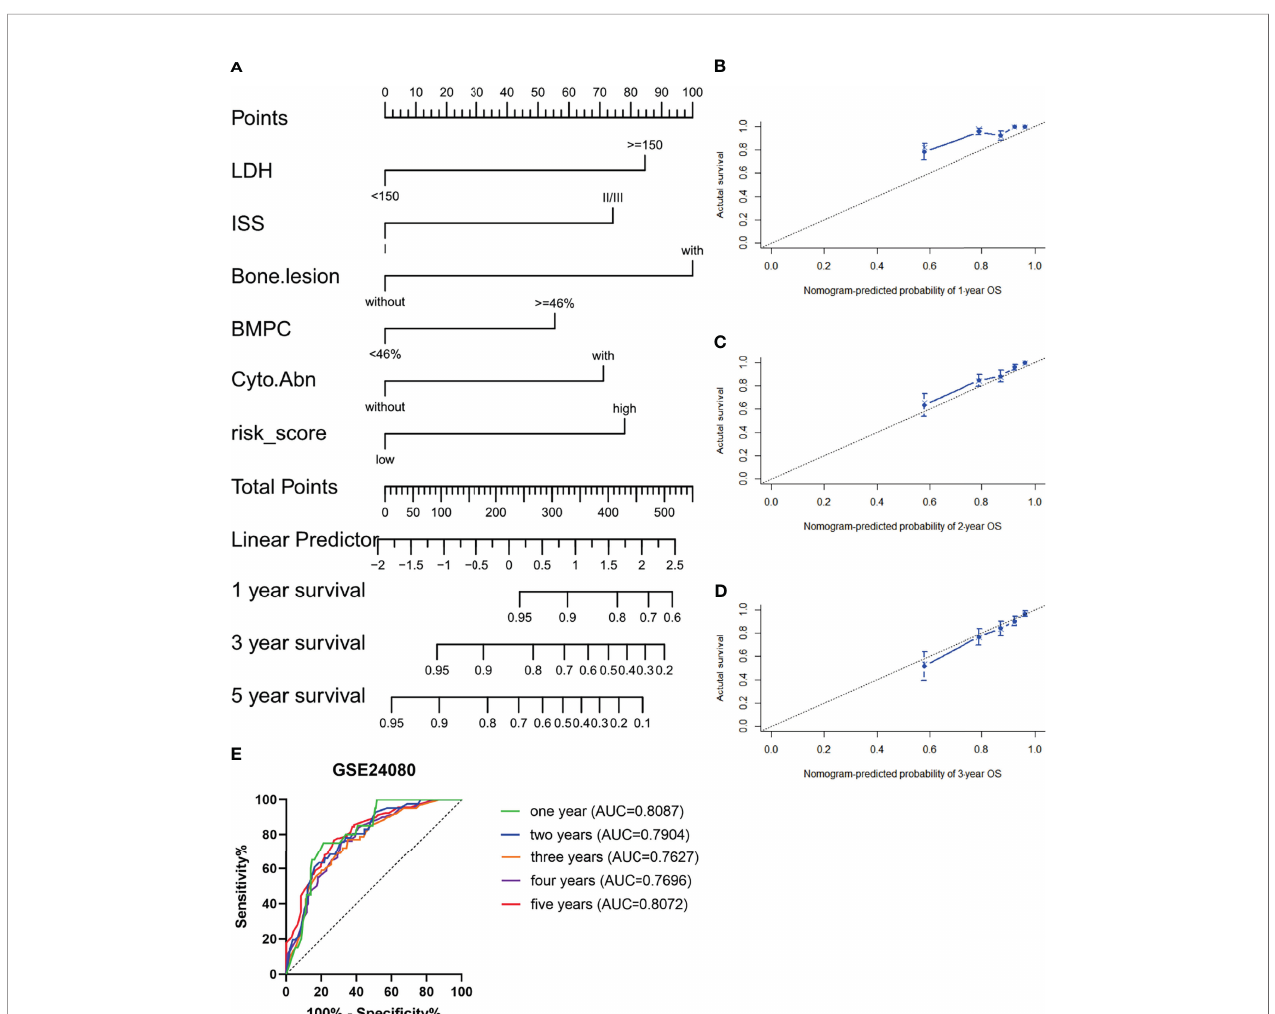
FIGURE 4 | Establishment and assessment of the nomogram. (A) Nomogram predicting 1-, 3-, and 5-year survival for MM patients in the training cohort based on the risk score and other clinical parameters. (B – D) Calibration plot of the nomogram for 1-year (B) , 2-year (C) , and 3-year (D) OS in the training cohort. (E) ROC curve in the GSE24080 for the nomogram risk score